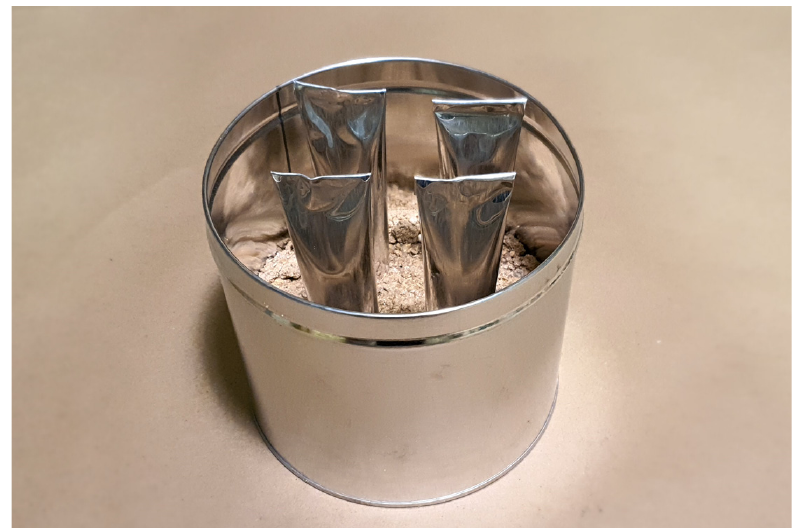
Figure 4. The vertically positioned tube.